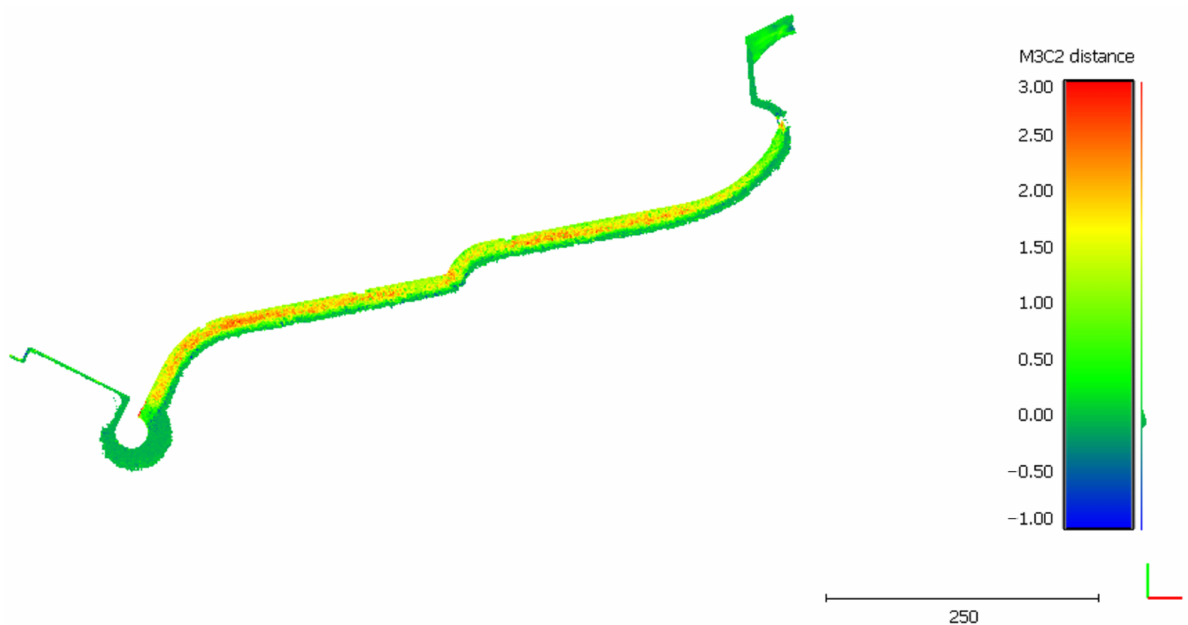
Figure 10. Comparison between DSM 1 (reference) and DSM 2 (compared) on the emerged breakwater, with distance values limited within the interval ( − 1; 3) m.